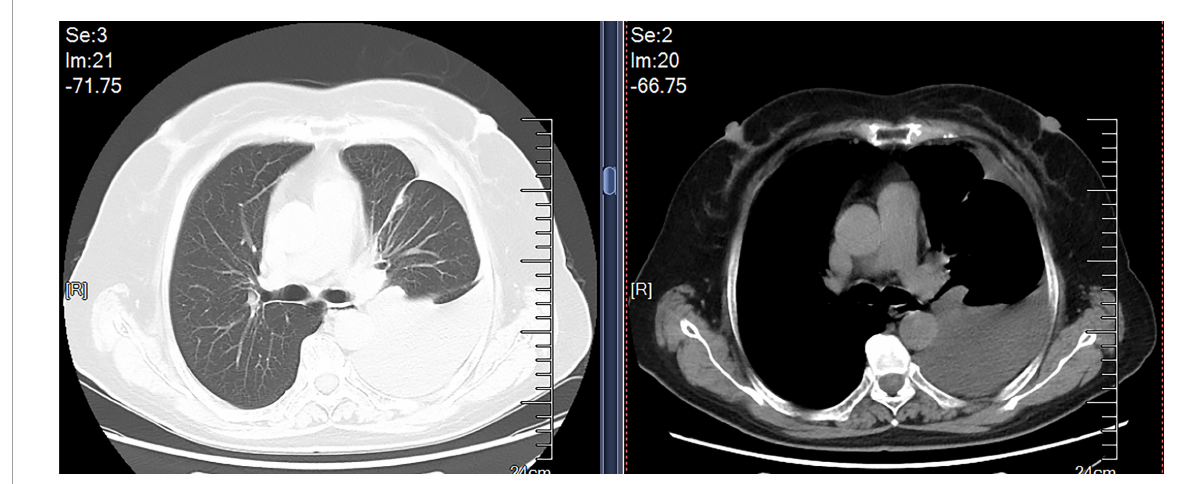
FIGURE1 Chest CT scan showed left pleural effusions and linear opacity.